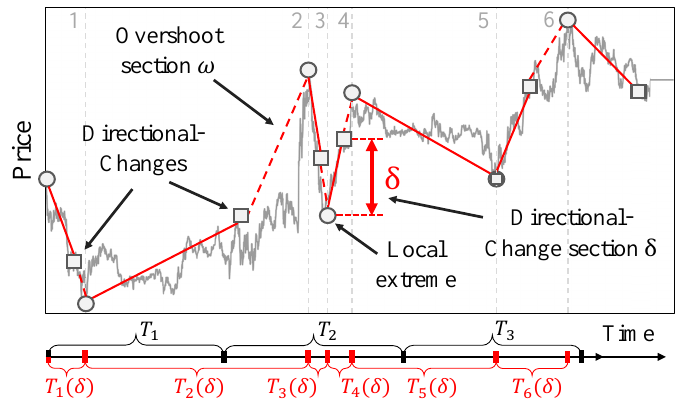
Figure 1. A part of EUR/USD price curve (grey) dissected into a set of directional-changes (grey squares) using a directional-change threshold δ . The size of the arbitrary chosen threshold is presented in the middle of the figure. Grey circles mark local extremes between two consecutive directional changes. The vertical distance between each directional-change and preceding extreme price is bigger or equal to the size of the threshold δ . Vertical dashed lines indicate the end of each trend section (identified only after the next event becomes observed) and go through the local extremes (circles). The timeline below the plot contains equal time intervals T 1 , T 2 , T 3 and length of each directional-change section T 1 ( δ ) , . . . , T 6 ( δ )